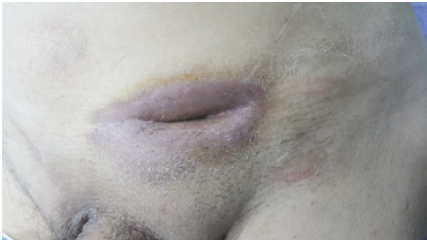
Figure 1: Photo of the fistula opening. The fistula remained after deep mesh infection with Ps. aeruginosa despite the initial conservative treatment and surgical intervention.